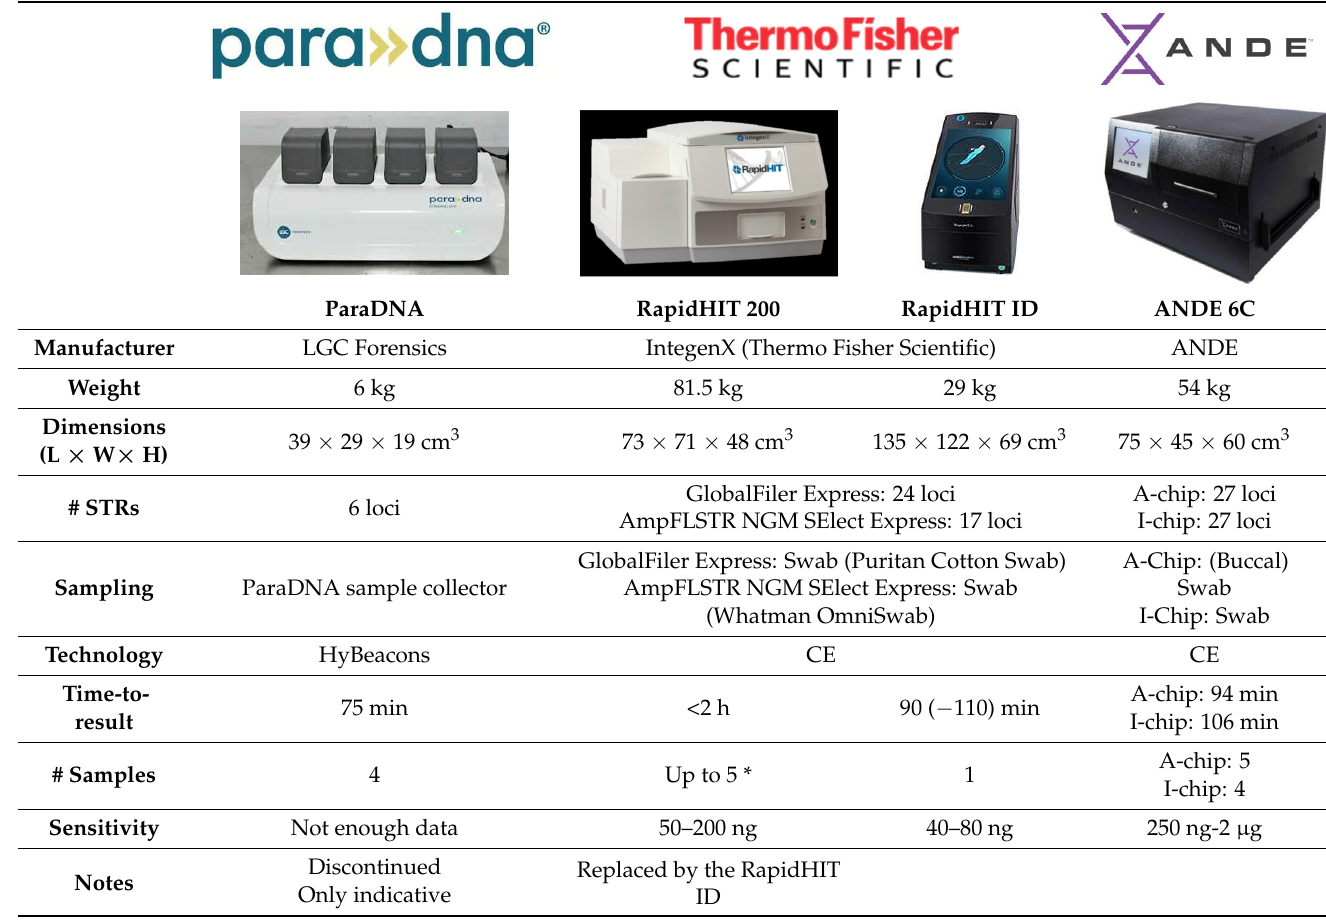
Table 1. Characteristics of the ParaDNA, RapidHIT 200, RapidHIT ID and ANDE systems.